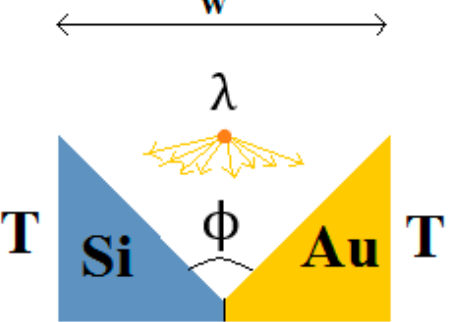
Figure 16. V cavity of asymmetric sides formed of Au & Si.